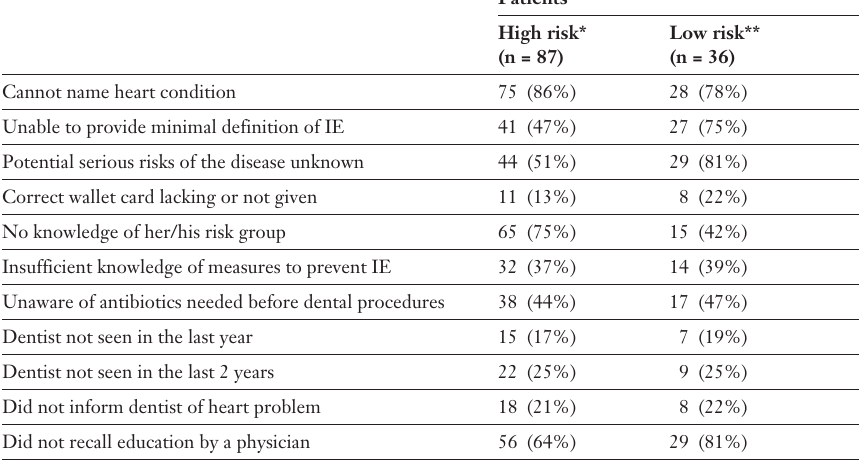
Table 4 First survey: Replies of all patients to questions on IE and EP.